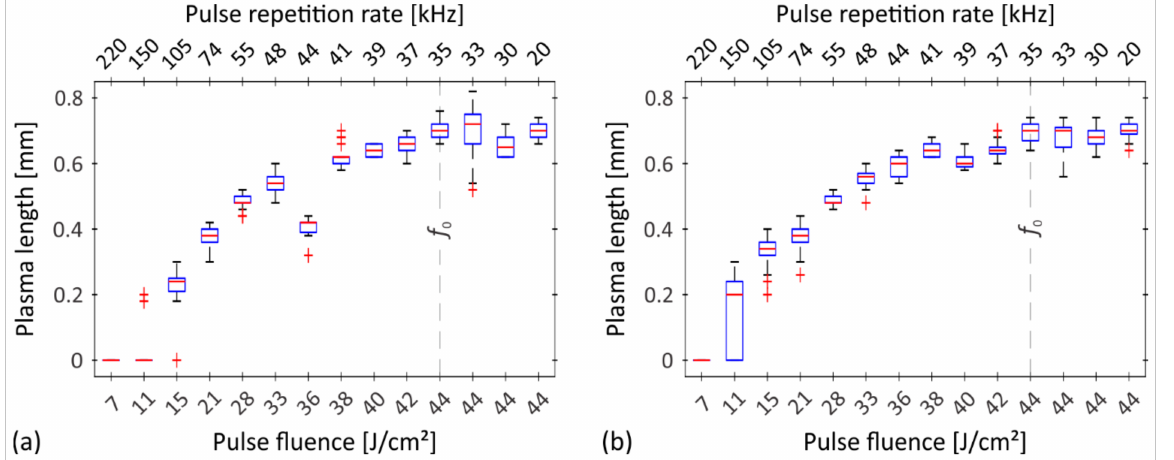
Figure 7. Plasma length as a function of pulse fluence when processing ( a ) brass CuZn37 and ( b ) steel AISI 316L. Outliers are marked with the red plus